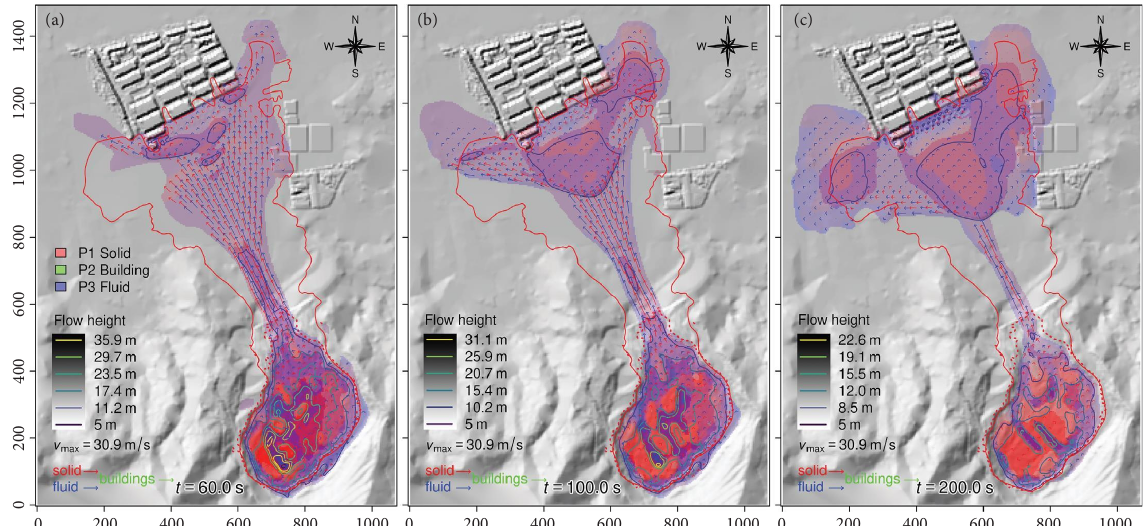
Figure 7: Te morphological characteristics of the landslide in simulation (II) without the obstructing buildings. (Te red dashed circle marks a local area for comparison between the simulations).